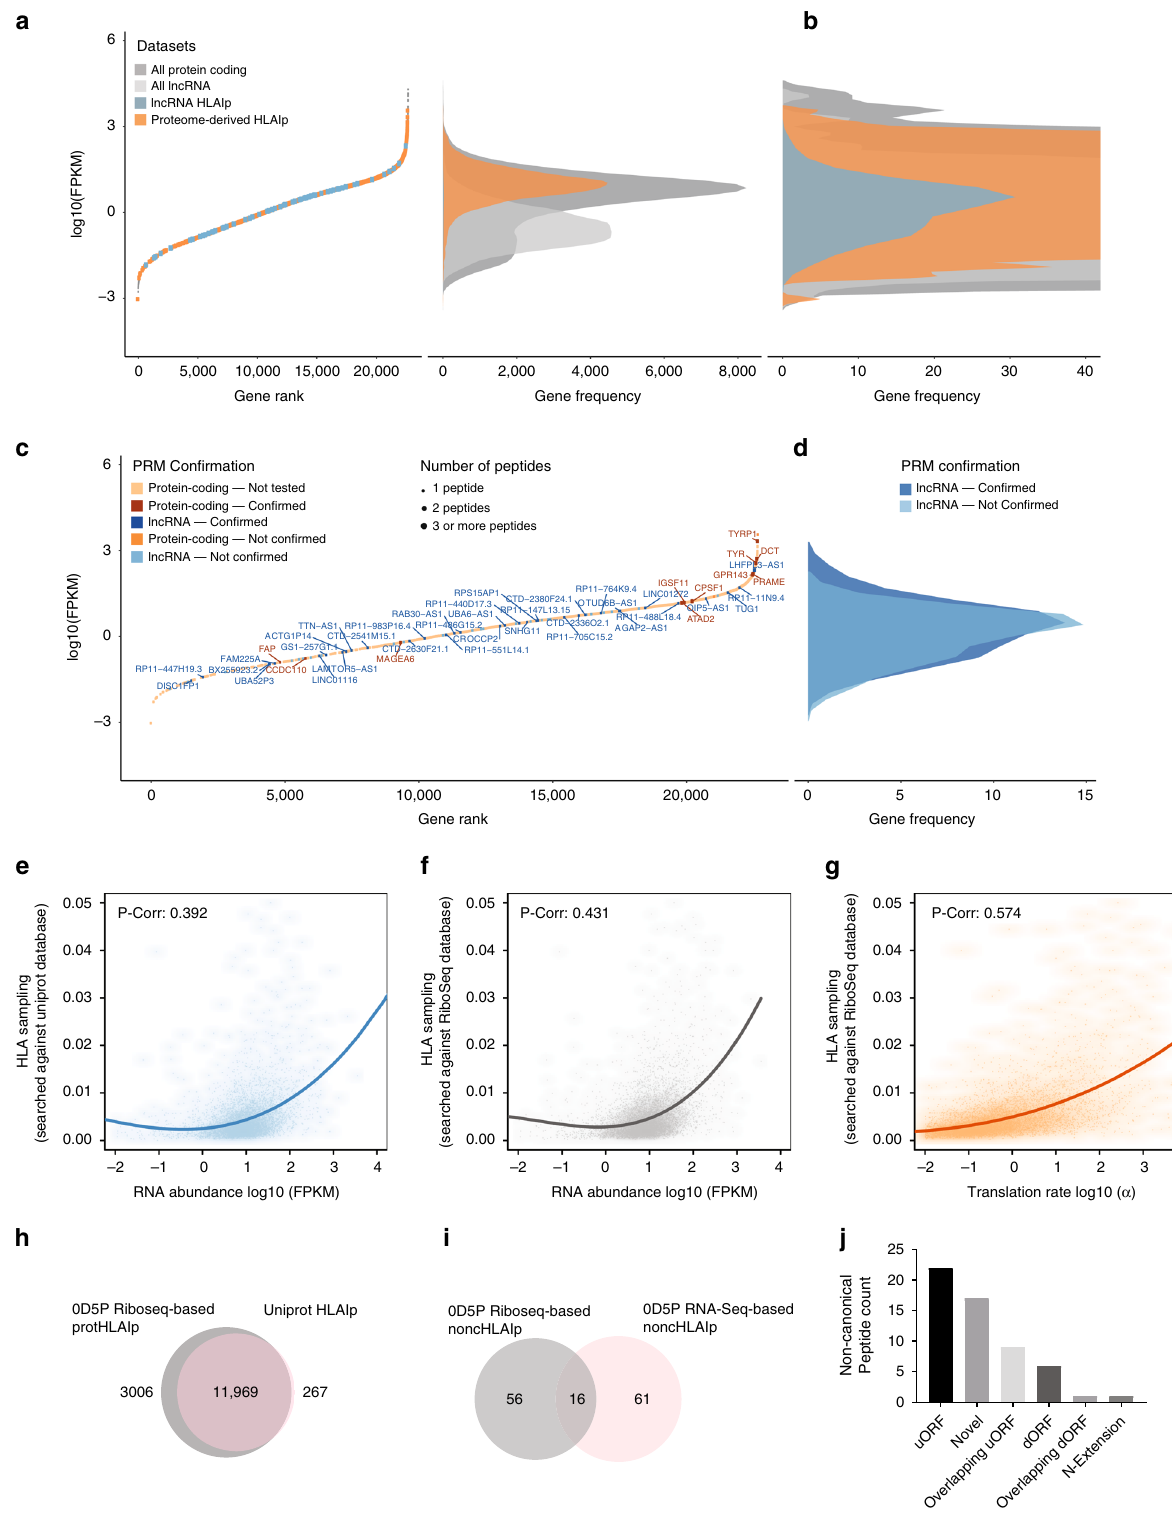
PRM Confirmation Protein-coding — Not tested ConfirmedProtein-coding — confirmedlncRNA — Protein-coding — Not